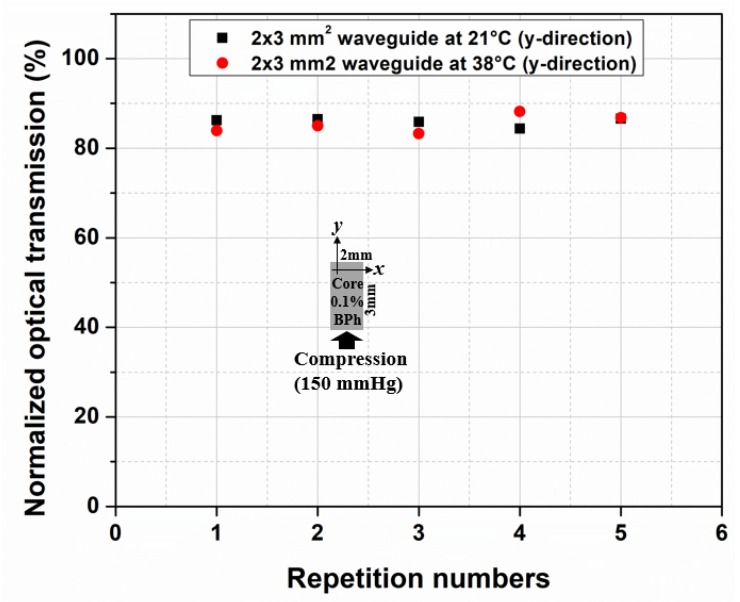
Figure 10. Normalized transmission of the air-clad PDMS waveguide (2 × 3 mm 2 ) under a fixed 150 mmHg load in the y -direction for 5 repetitions.